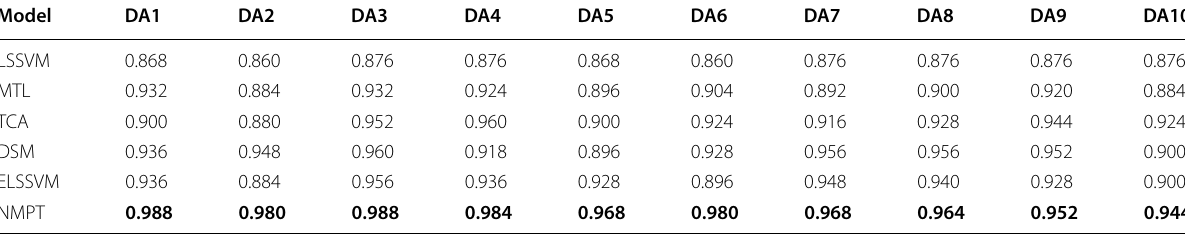
Table 3 Total GFD accuracies from test DA1 to DA10